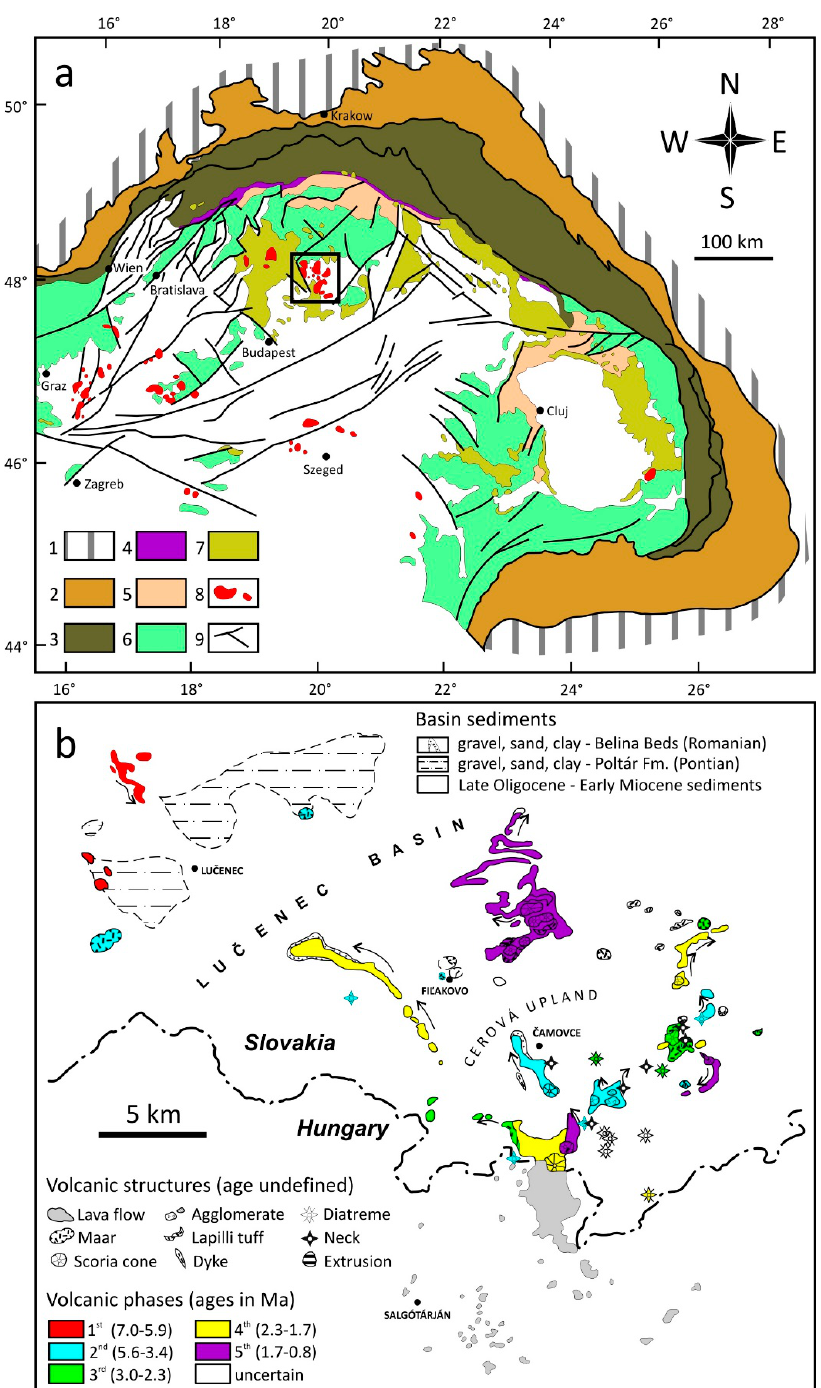
Figure 1. ( a ) Schematic drawing of the Carpathian arc and the intra-Carpathian back-arc basin modified after [22]: 1: European platform; 2: foredeep; 3: Tertiary accretionary wedge; 4: Klippen belt, 5: Palaeogene back-arc basin; 6: Variscan crystalline basement with pre-Tertiary sedimentary cover and Mesozoic nappe units (Cretaceous accretionary wedge); 7: Neogene andesites and rhyolites; 8: Upper Miocene-Quaternary alkali basalt volcanism; 9: major normal, strike-slip and thrust faults. The rectangle marks the South Slovakian–North Hungarian Volcanic Field. ( b ) Enlarged view of the study area with volcanic phases as indicated by K/Ar dating of lava flows [30], U/Pb zircon, U/Th monazite, (U-Th)/He zircon and apatite dating of maars ([21,31–33] and unpublished data).